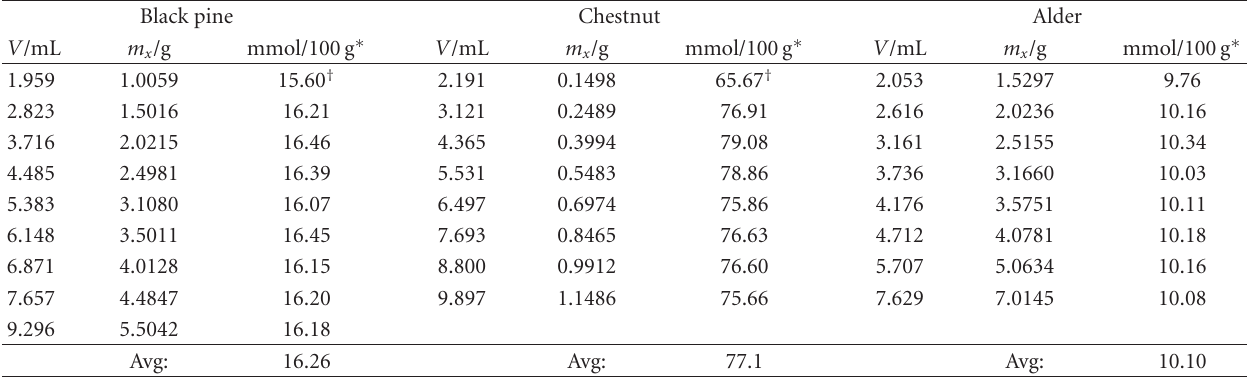
Table 3: Estimation of wood acidity by means of titration of wood-phosphate solutions.